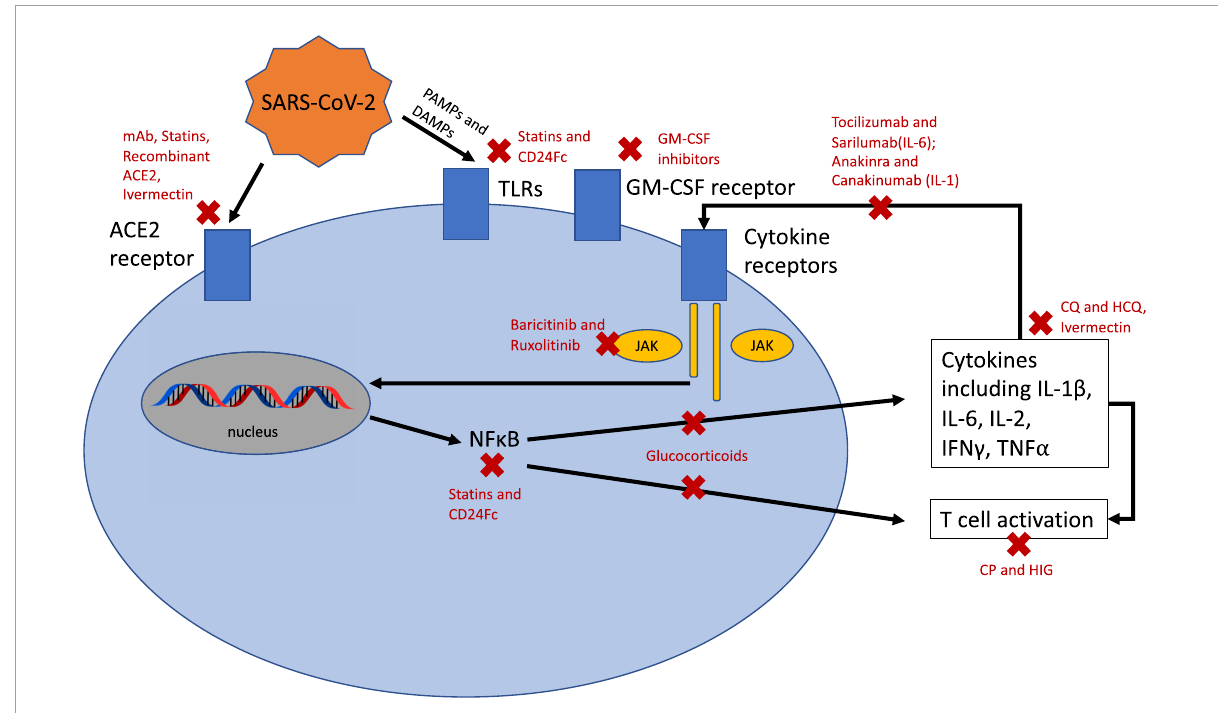
FIGURE2 Mechanisms of action for therapeutics with potential benefit in SARS-CoV-2 infection. ACE2, angiotensin converting enzyme 2; TLRs, toll-like receptors; JAK, Janus kinase; NF κ B, nuclear factor Kappa B; IL, interleukin; IFN, interferon; TNF, tumor necrosis factor; CP, convalescent plasma; HIG, hyperimmune globulin; CQ, chloroquine; HCQ, hydroxychloroquine; GM-CSF, granulocyote-monocyte colony stimulating